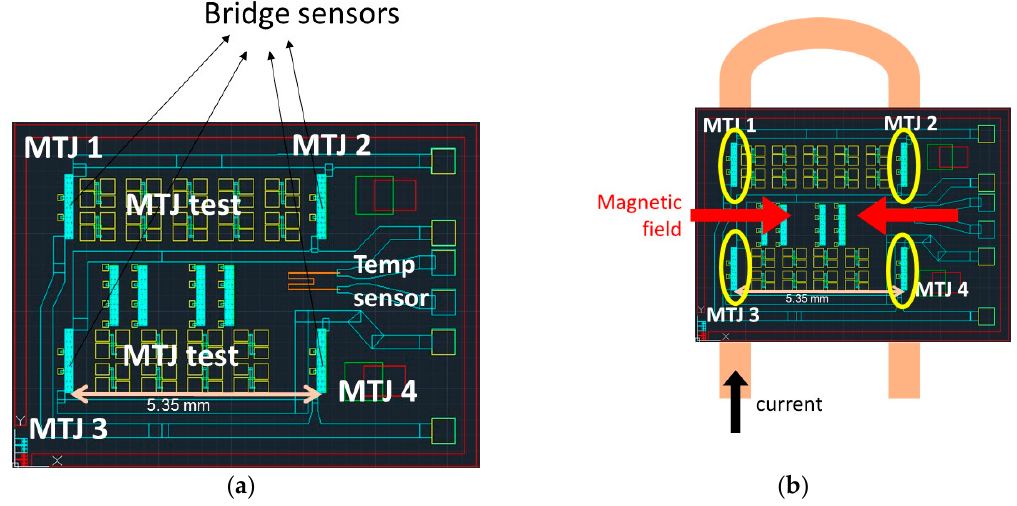
Figure 1. ( a ) Design of the chip with the four magnetic tunnel junction (MTJ) sensors connected in the Wheatstone bridge, several MTJ test elements, and a temperature sensor [30]; ( b ) Operation schematics, showing the opposite field created at each pair of MTJ elements by the U-shaped test current line.